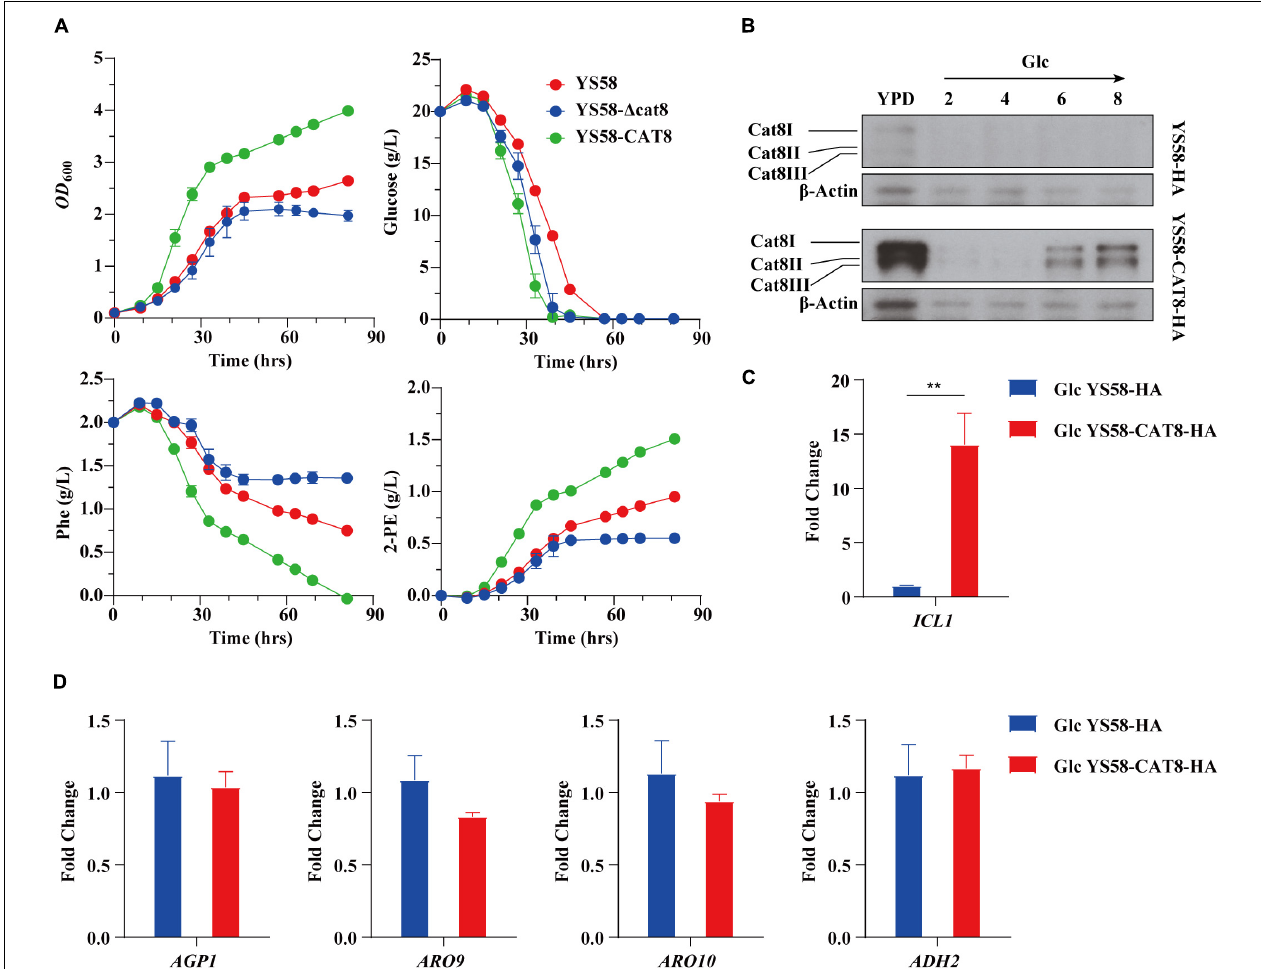
FIGURE 1 | Effect of Cat8 on 2-PE biosynthesis and the transcriptional activity of Cat8 in the presence of glucose. (A) Cell growth, residual sugar, Phe, and 2-PE contents. Yeast strains were cultured in fermentation medium at 30 ◦ C and 200 rpm. (B) Cat8 level assay. Cells were cultured in YPD overnight and transferred to fermentation medium with glucose as the only carbon sources for 6 h at 30 ◦ C and 200 rpm. Samples were taken at indicated times. Cell free extracts (2 µ g protein) were subjected to immunoblot analysis using polyclonal anti-HA and β -Actin antibodies. (C) Transcriptional levels of Cat8 target gene ICL1 . (D) Transcriptional levels of genes involved in Ehrlich pathway. For (C,D) , yeast cells were cultured in fermentation medium with glucose as the only carbon source at 30 ◦ C and 200 rpm for 6 h. Data shown are mean values ± SDs of triplicates. Statistical difference was determined by two-tailed Student’s t -test, ** p < 0.01.